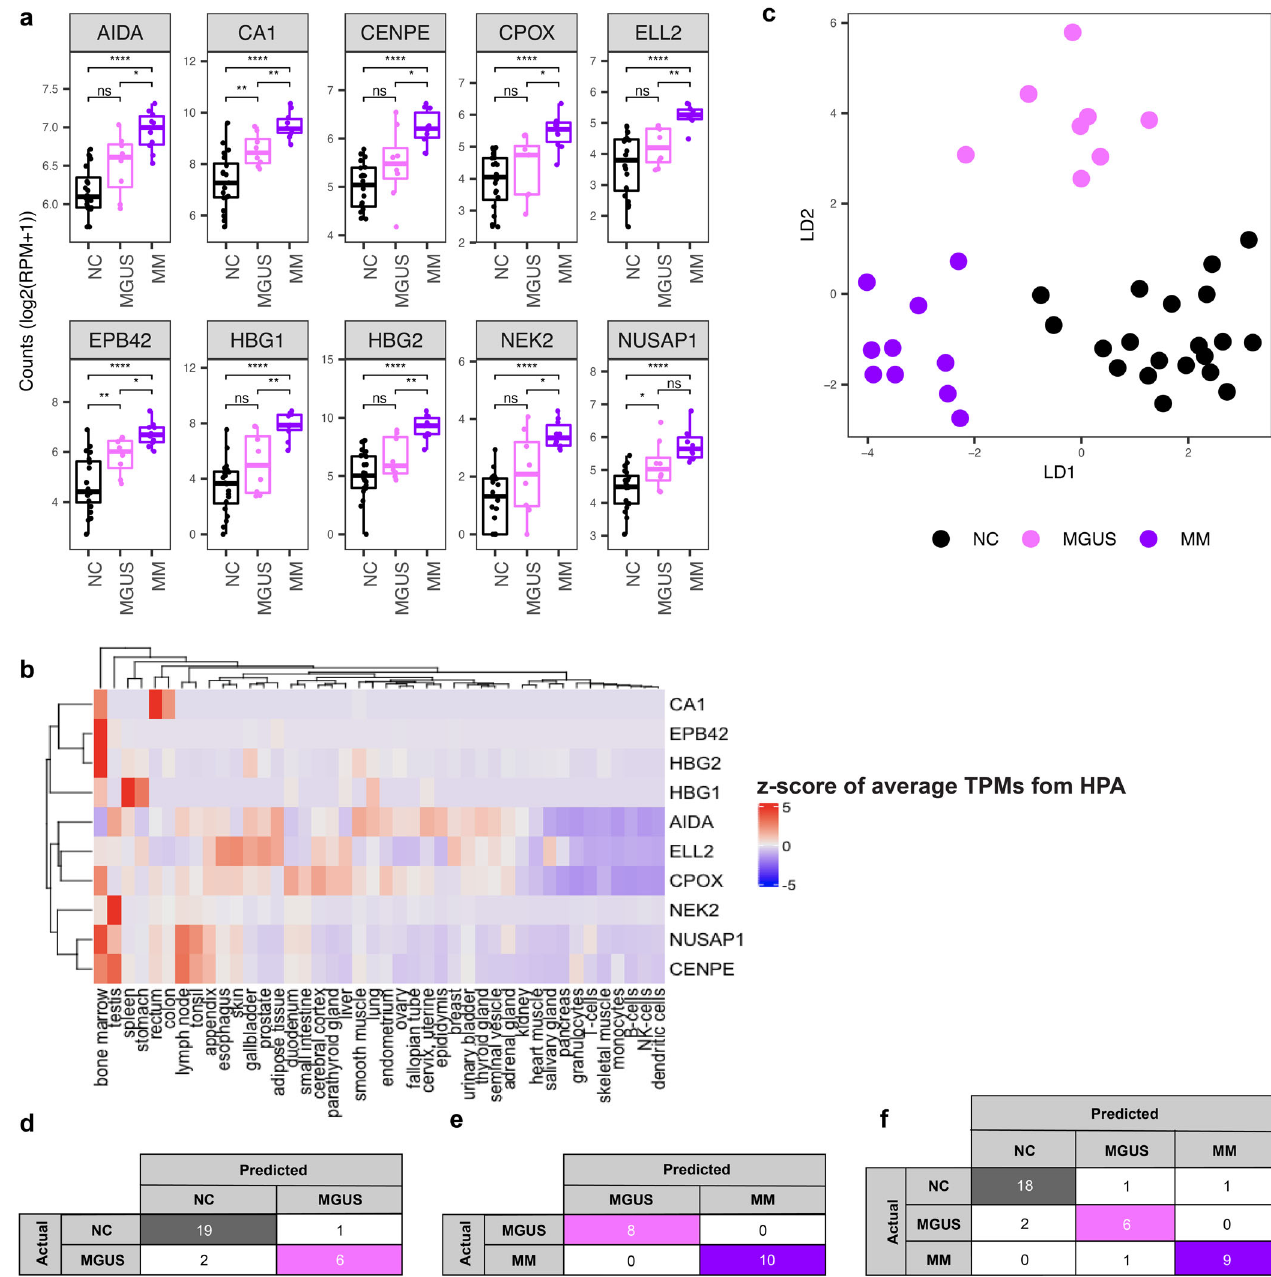
Fig. 2 cfRNA pro fi les distinguish between non-cancer, MGUS, and multiple myeloma donors. a Boxplots of representative top ten most signi fi cant genes resulted from the LVQ analysis for MM versus NC. P value was calculated for each pair by the t -test. Center-line indicates the median value across all patients in that group, and the hinges represent the lower (Q1) and upper (Q3) quartile, with whiskers extending to the minimum and maximum of the resulting distribution. b Heatmap of z -score across publicly available tissue-level expression data from the Human Protein Atlas (HPA) for the top ten LVQ genes identi fi ed in MM vs. NC. c LDA plot using ten genes from pairwise analysis across NC - MGUS and NC - MM pairs using the LVQ method. d – f LOOCV using the Random Forest (RF) model with top ten LVQ genes to discriminate MGUS and NC ( d ), MM vs MGUS ( e ), and three groups NC, MGUS, and MM ( f ). Genes included in the RF analysis are listed in Supplementary Table LVQ algorithm (HBG1, HBG2, NUSAP1, for MM and C3, CP, FGA, Table 1 and Supplementary Figs. 6, 7). We validated the cfRNA FGB for HCC) from RNA-sequencing were also observed with RT- biomarkers identi fi ed from the pilot set in silico by measuring the classi fi cation accuracy on this independent sample set using the qPCR (Fig. 4b). To con fi rm that the feature sets and classi fi cation models models trained with the pilot dataset using the LVQ gene sets. The linear combination identi fi ed by LDA in the pilot cohort of the LVQ de fi ned in our pilot cohort were robust and generalizable, we feature set showed signi fi cant separation in the validation sample collected a set of independent validation samples from ten NC set between MM and HCC from NC donors, consistent with our controls, nine MM patients, and 20 HCC patients (Supplementary